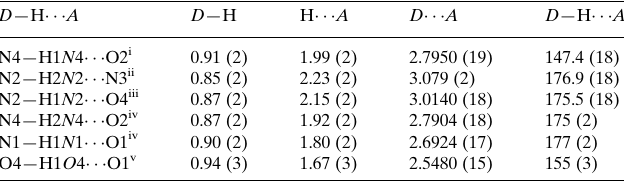
Data collection Bruker SMART APEXII DUO CCD area-detector diffractometer Absorption correction: multi-scan ( SADABS ; Bruker, 2009) T min = 0.838, T max = 0.932